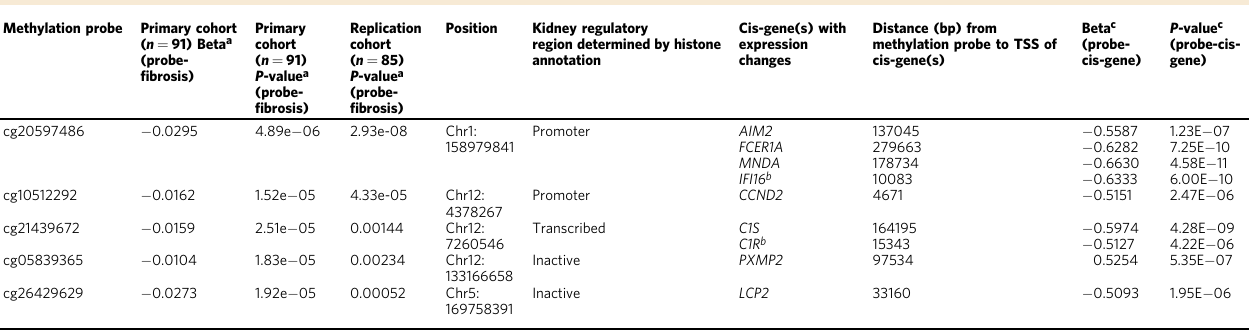
Table 3 Top replicated probes associated with interstitial fi brosis and gene expression changes Methylation probe Primary cohort ( n = 91) Beta a